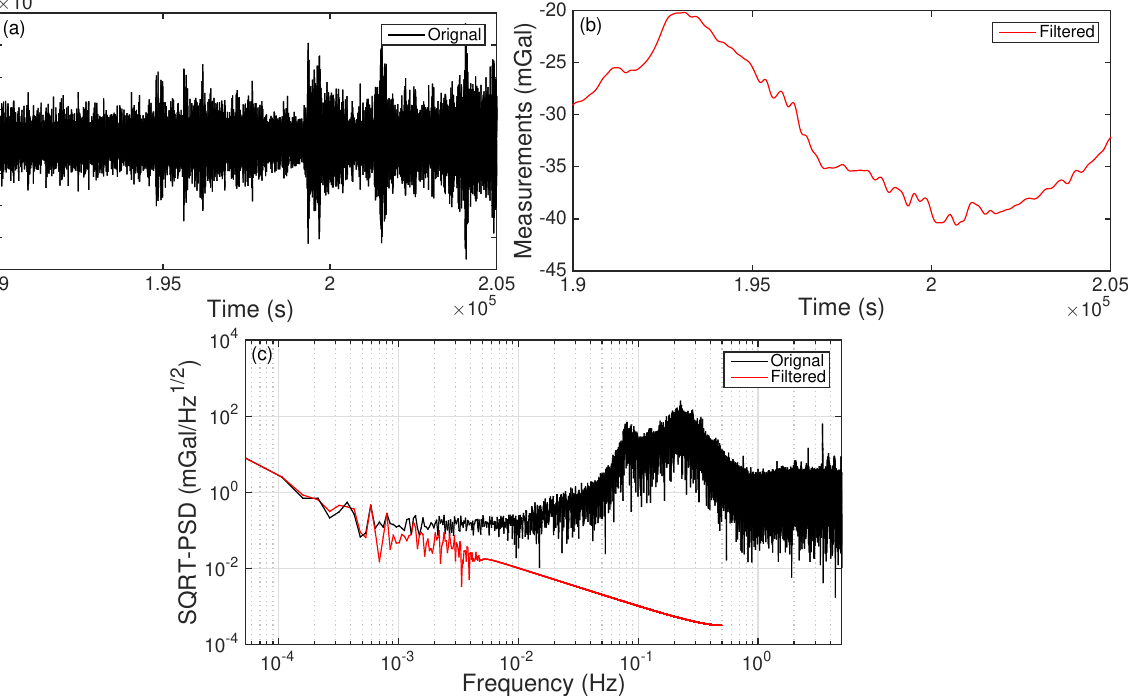
Figure 4. A typical track from the campaign DENEB2017: ( a ) unfiltered Chekan-AM measurements, ( b ) filtered Chekan-AM measurements and ( c ) the respective power spectral densities